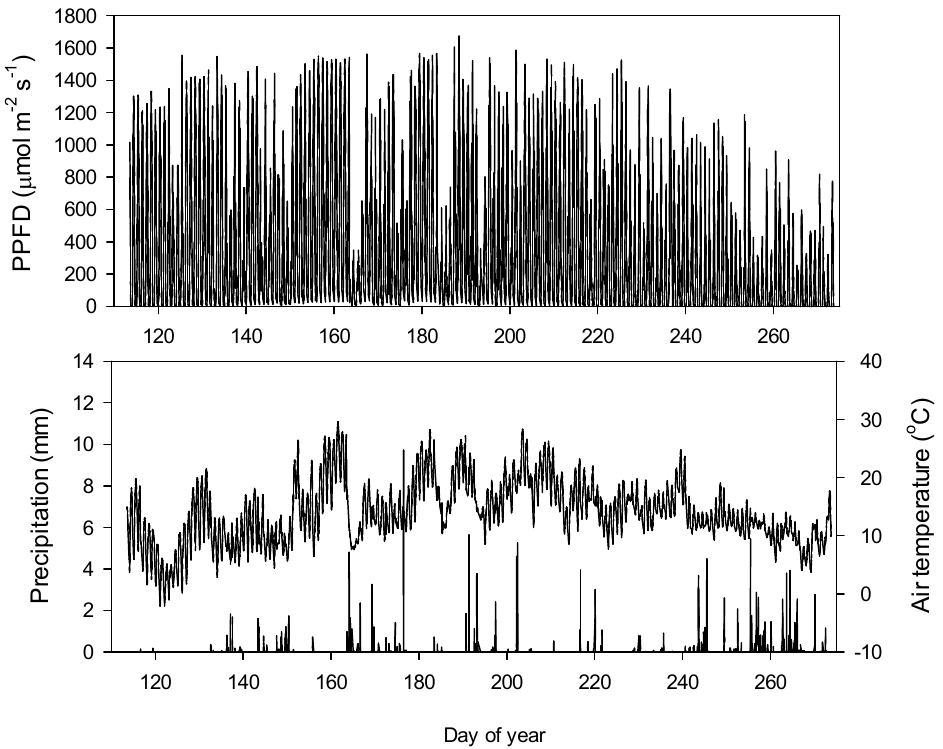
Figure 1. Seasonal course of meteorological conditions measured at the SMEAR II station during the sampling period. Top panel shows 30 min means of photosynthetic photon flux density (PPFD). The time series in the bottom panel shows 30 min means of air temperature measured at 17 m above the ground while vertical bars represent 30 min sums of precipitation.